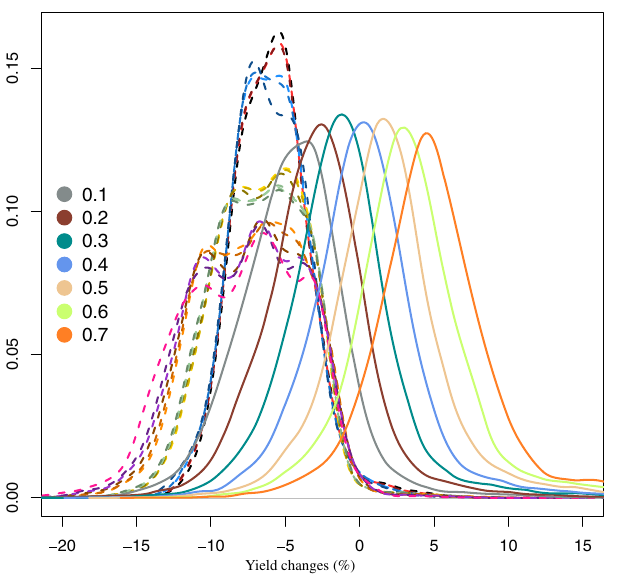
Fig. 5 Effects of the idealised climate service on changes in yield interannual variability. Spatial probability density functions of the ensemble changes in the yield interannual variability (ratio 2021 – 2040, 1986 – 2005) estimated for each ideotype (dotted line) and for the simulations integrating the idealised climate service with different skill (bold lines and according to the colours from 10% to 70%).